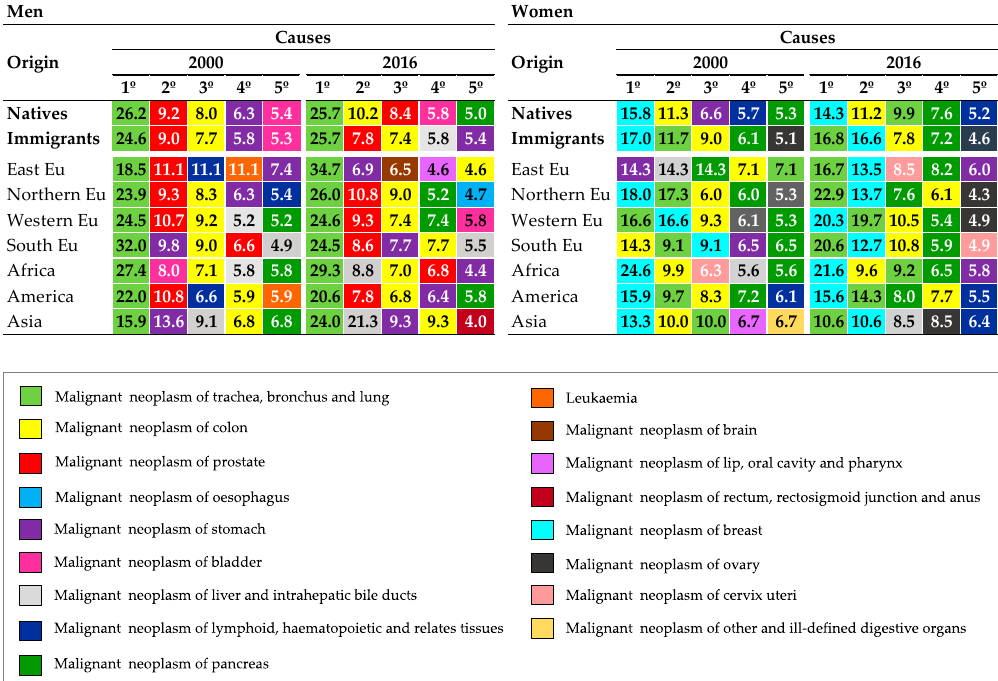
Figure 5. Proportional mortality, five main causes of death by type of cancer in men and women (natives and immigrants) according to region of birth, in 2000 and 2016.